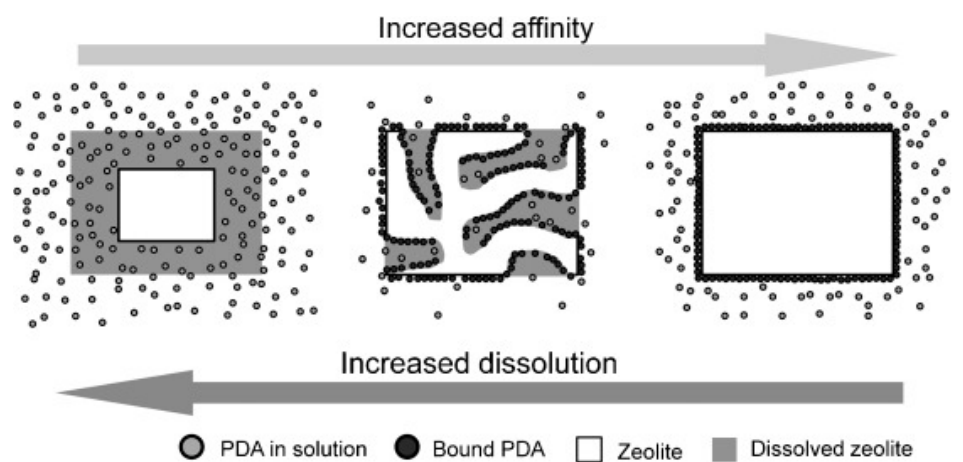
Figure 6. Illustration of how the affinity of PDA to the zeolite surface influences the rate of zeolite dissolution and the formation of mesopores [67]. Copyright (2011), with permission from Wiley.